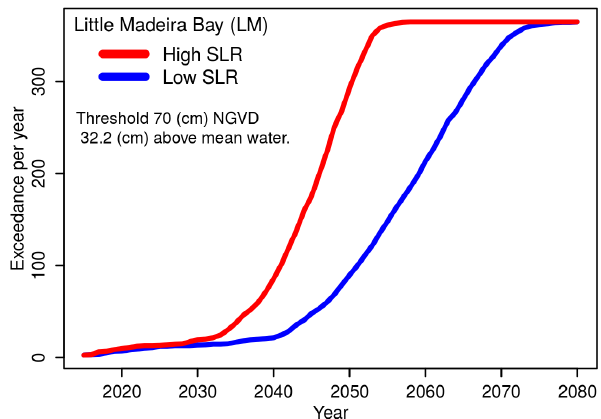
Figure 11. Projected evolution of water level exceedances at Little Madeira Bay under the low and high sea level rise scenarios. Mean water is the daily mean water level over the three-year period from January 2014–December